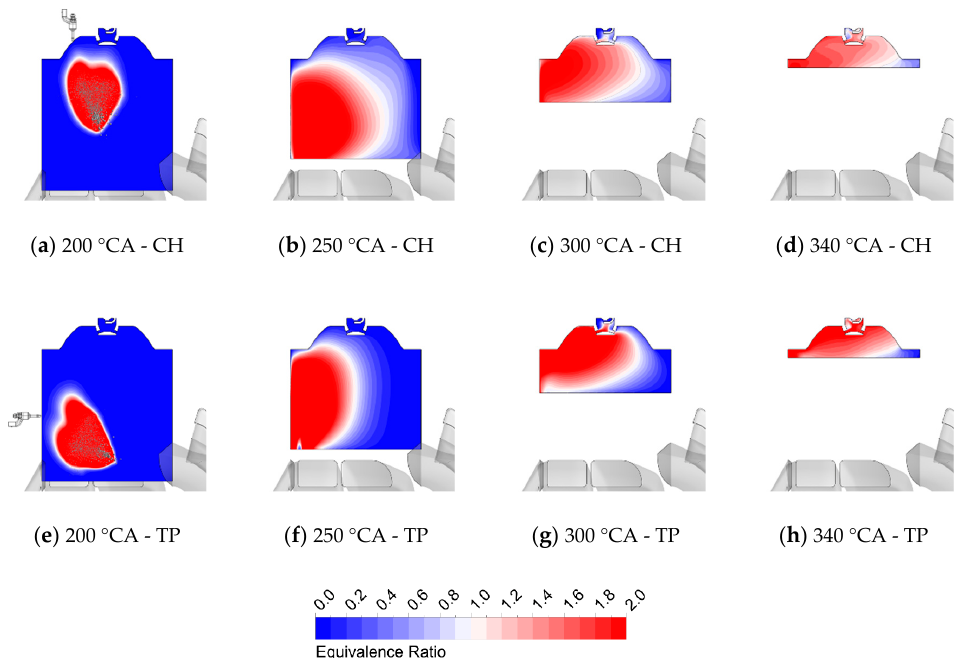
Figure 17. Spray behavior and equivalence ratio contours at 2500 rpm and 10% load with PN6 prechamber for both injection strategies.